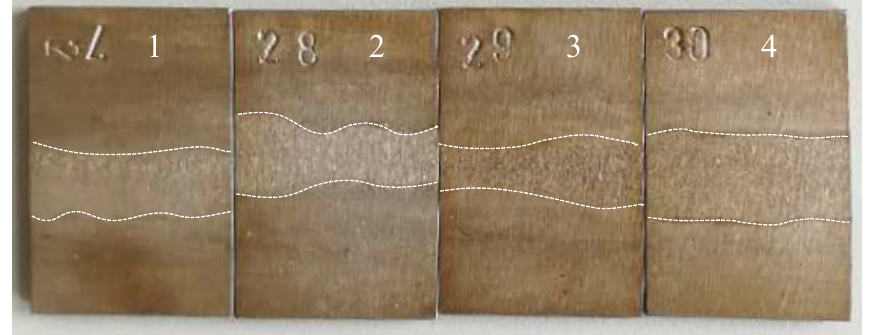
Figure 12. Images of intergranular corrosion welded joints with different treatments methods: 1—untreated; 2—pneumatic chipping hammer; 3—ultrasonic peening treatment; 4—heat treatment.